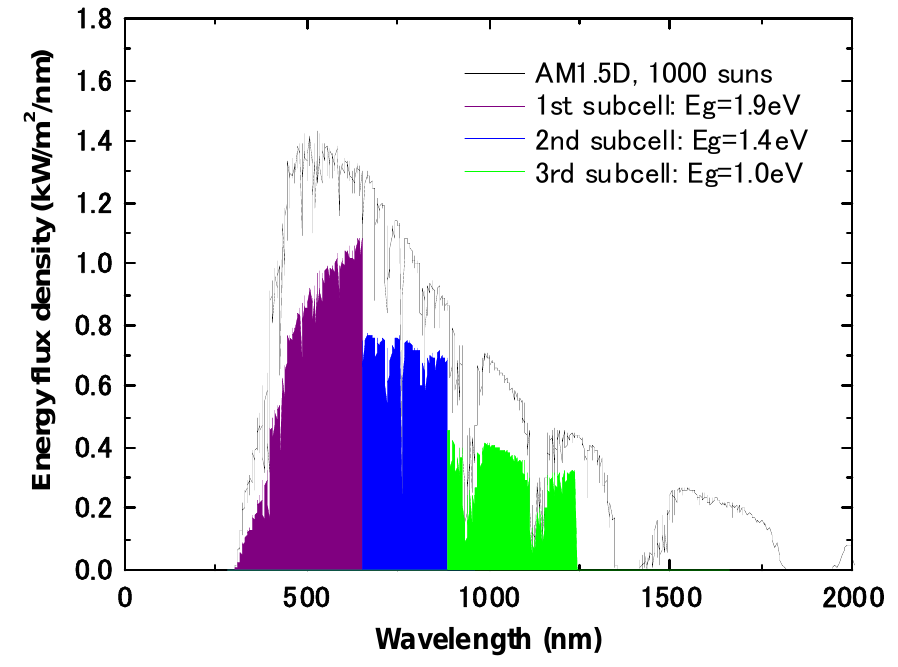
Figure 9. Solar irradiation spectrum of AM1.5D, 1,000 suns and energy utilization spectrum by a series-connected AlInGaP (1.9 eV) / GaAs (1.4 eV) / 1.0 eV triple-junction solar cell calculated with the “detailed balance limit” scheme with current-match restriction. Calculated energy conversion efficiency η = 55.0% ( η = 44.4% under AM1.5G, 1